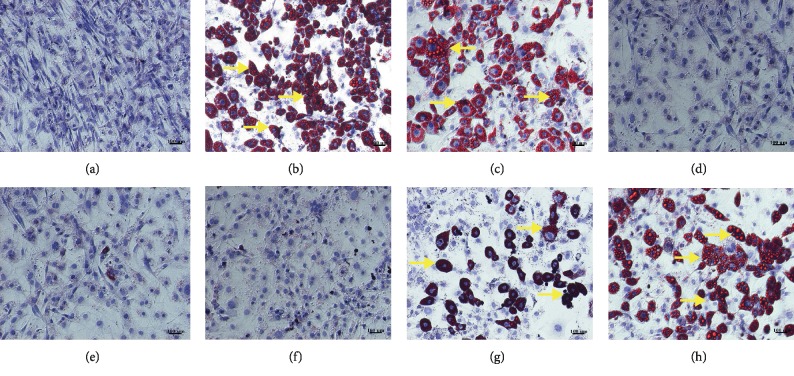
Morphology of 3T3-μL1 preadipocytes and adipocytes after staining with Oil Red O. Lipid droplets were stained in red color (yellow arrows). Nuclei were counterstained with hematoxylin, as indicated in blue color. (a) Nondifferentiated cells (ND) or preadipocytes. (b) Untreated adipocytes (CON). (c) Differentiated cells with 0.1% DMSO (V-CON). (d) Differentiated cells with 1.67 μg mL−1 simvastatin (SIM). Differentiated cells with OIE at (e) 200 μg mL−1; (f) 150 μg mL−1; (g) 100 μg mL−1; (h) 50 μg mL−1. (a–h) Scale bar represents 100 μm, at 10X magnification.